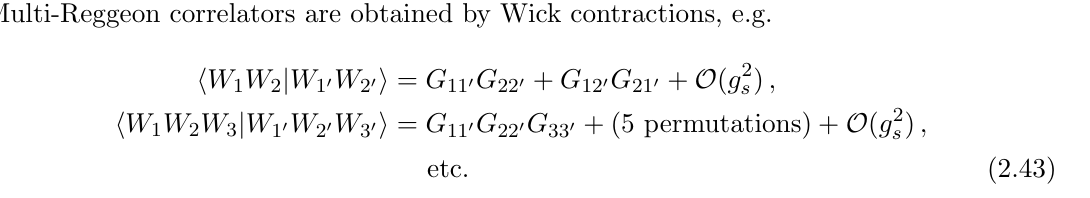
Multi-Reggeon correlators are obtained by Wick contractions,